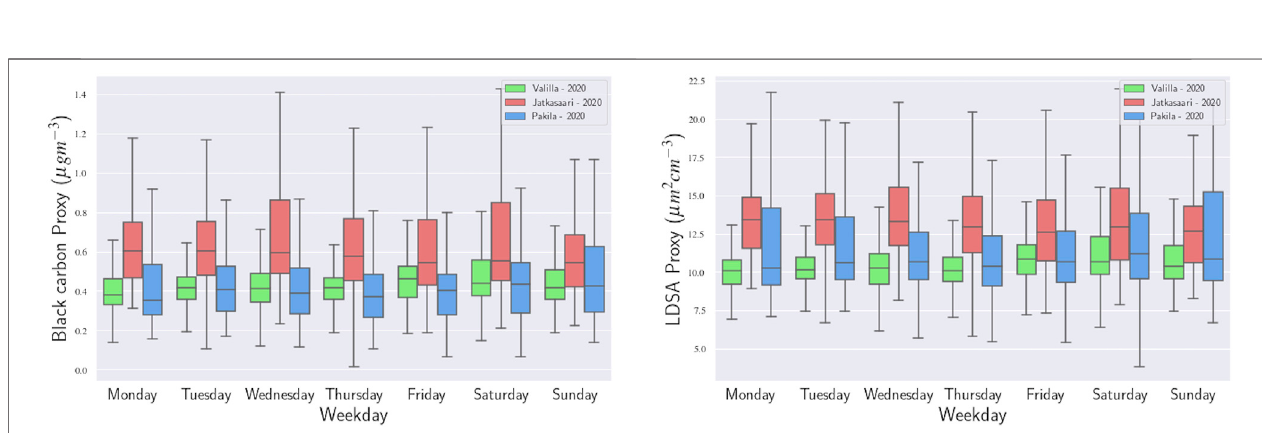
FIGURE 10 | Hourly black carbon and lung deposited surface area proxy concentrations derived from HOPE sensors measurements compared to time of measurement across the week for campaigns 2019 – 2020.